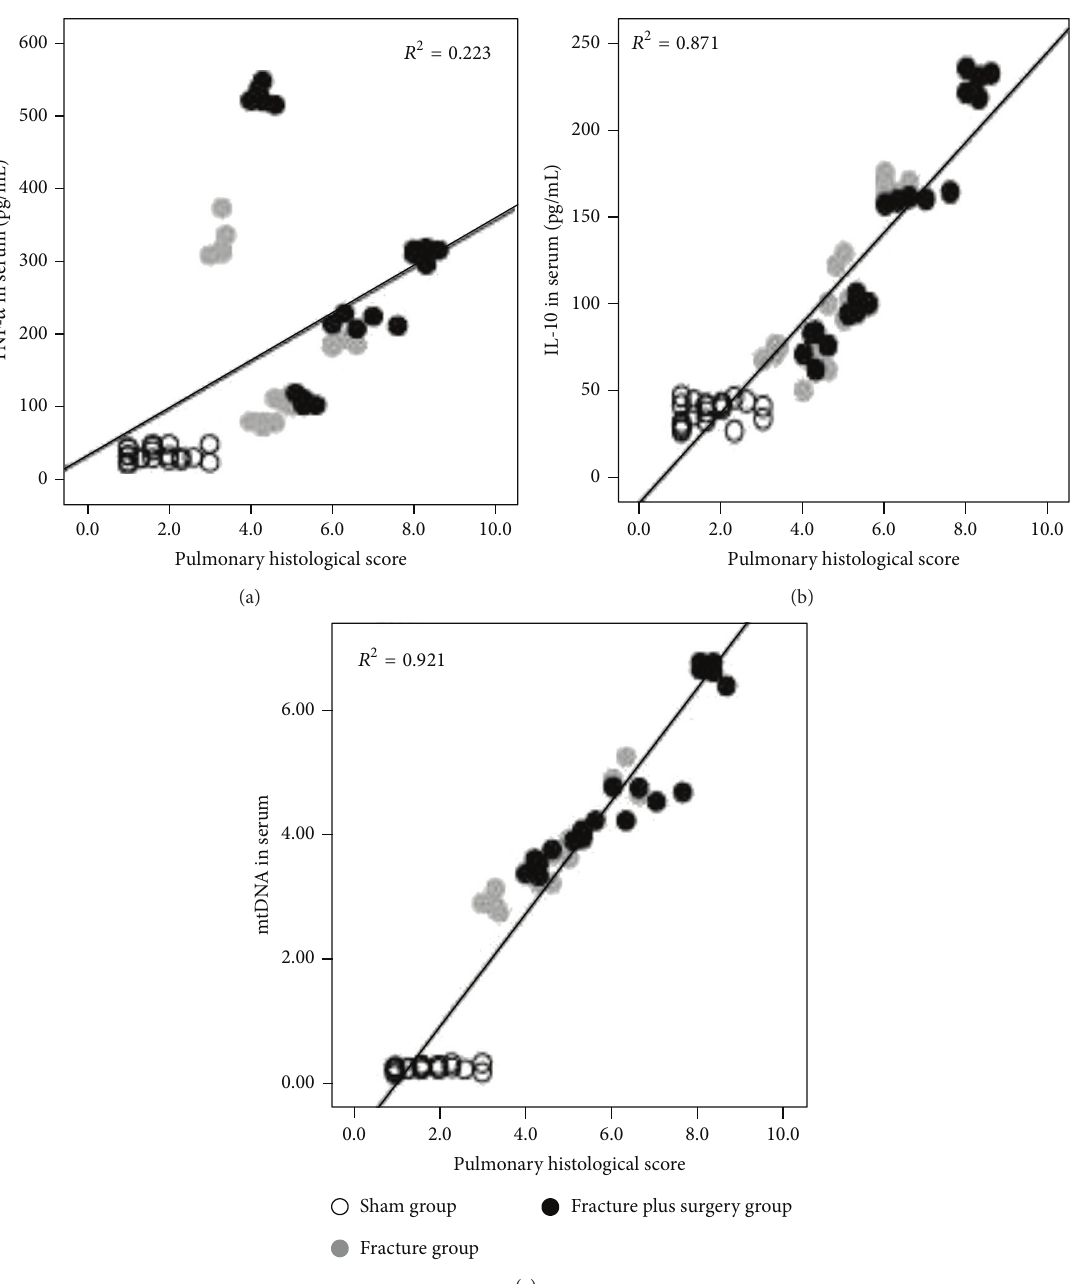
Figure 5: Scatter plots and regression lines showed that the serum TNF- 𝛼 (a) level was not significantly correlated with the pulmonary histological score; however, the serum IL-10 (b) and mtDNA (c) levels exhibited a significant relationship with the pulmonary histological